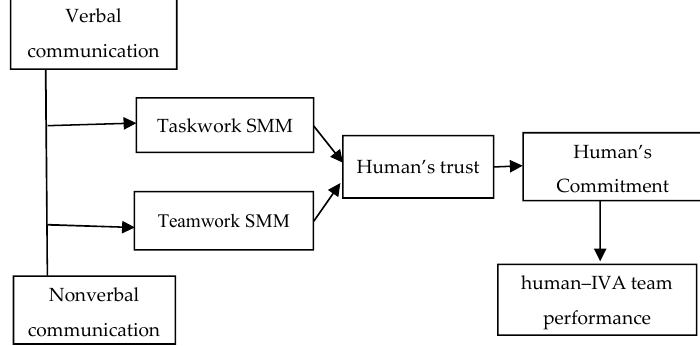
Figure 1 . Research model depicting the relationships between verbal and nonverbal communication, taskwork shared mental model (SMM), teamwork SMM, trust, commitment, and team performance. IVA: intelligent virtual agents.